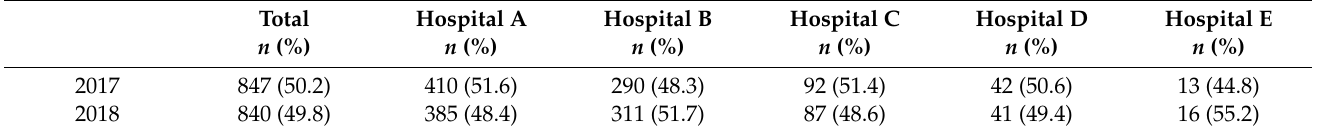
Table 3. Patients on ART a , in 2017 and 2018, by referral